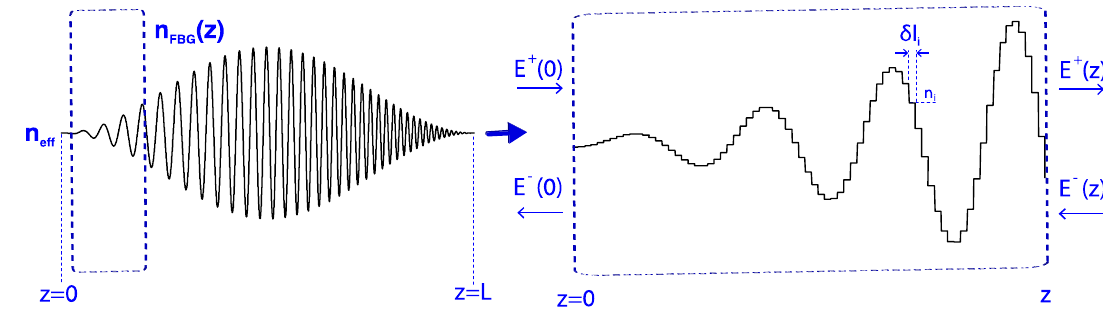
Figure 3. Representation of the division of a non-uniform FBG into layers suitable for the analysis using ML-TMM. The dependence of waves with the optical frequency is omitted for simplicity.